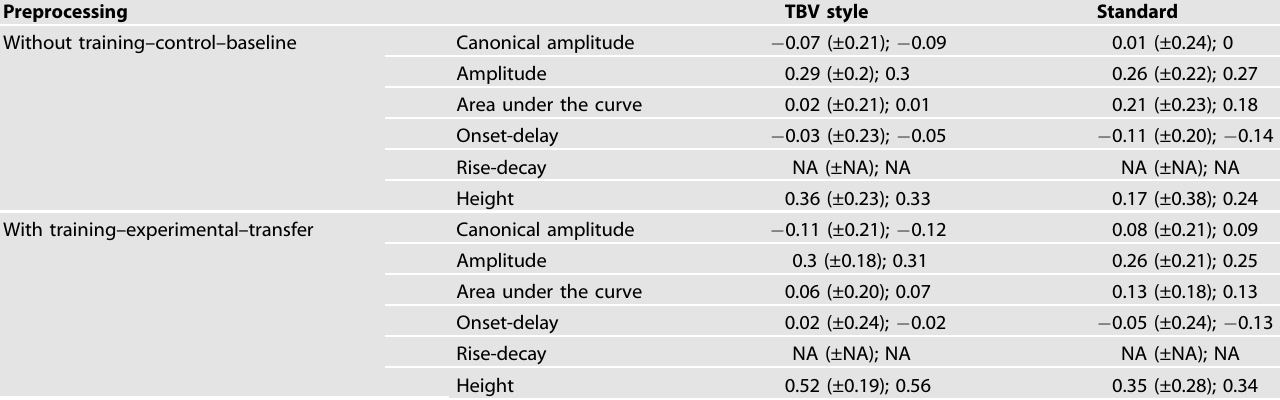
Table 4. Table of mean, standard deviation, and median values of ICCs for each sample, preprocessing, and fi rst-level parameter with cluster correction